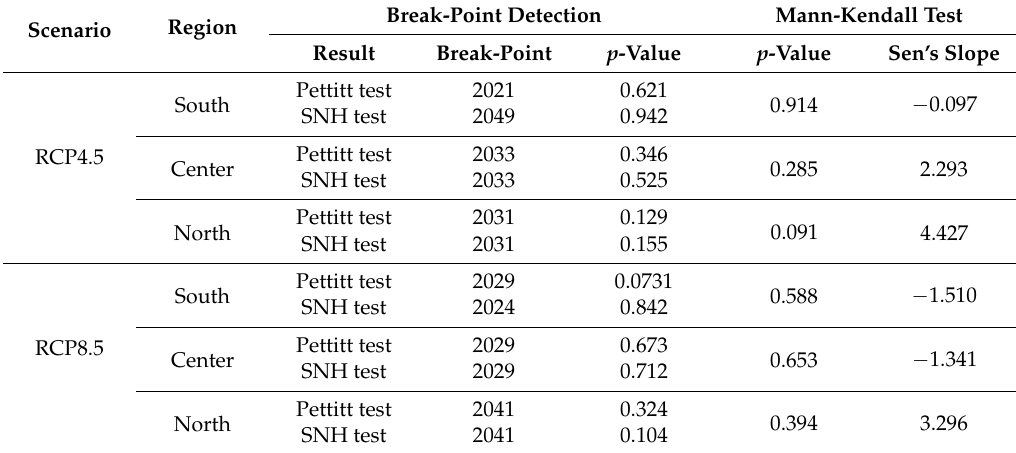
Table 4. Results of break-point detection and Mann-Kendall test on annual rainfall under RCP4.5 and